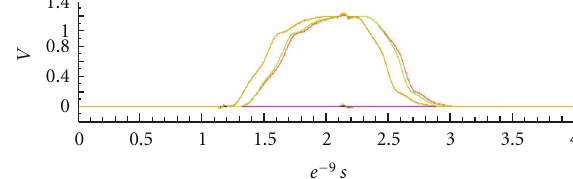
Figure 15: Outputs of the DES submodule block implemented on the secure FPGA.